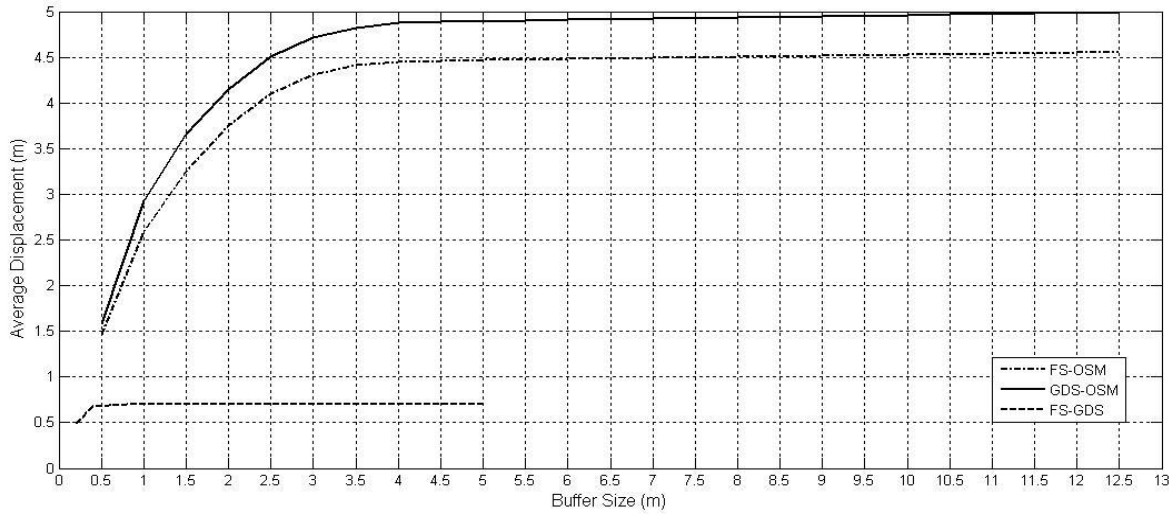
Figure 7. Average displacement information of roads in Baghdad,